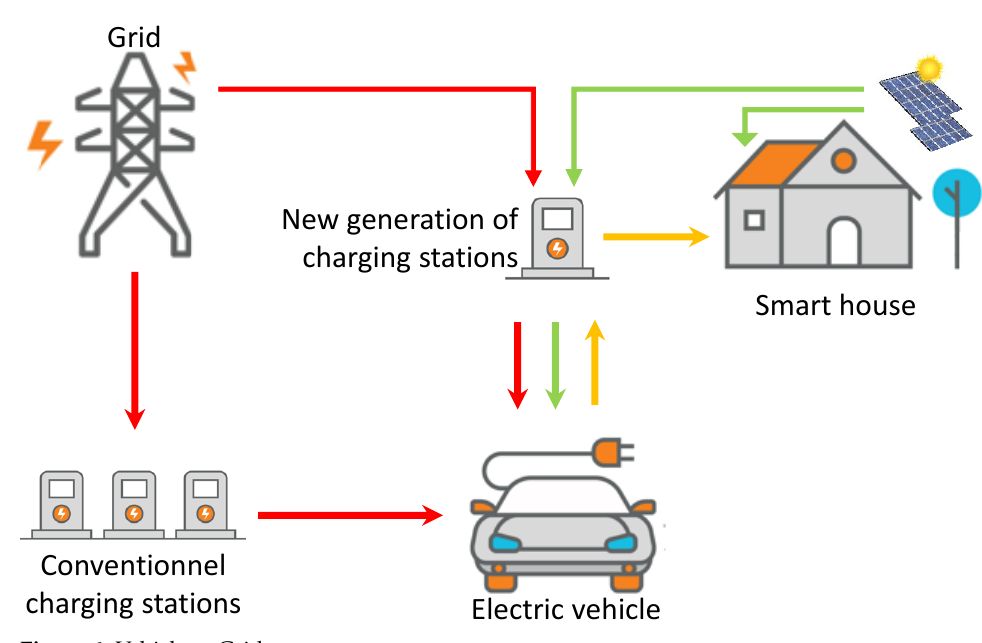
Figure 6. Vehicle to Grid